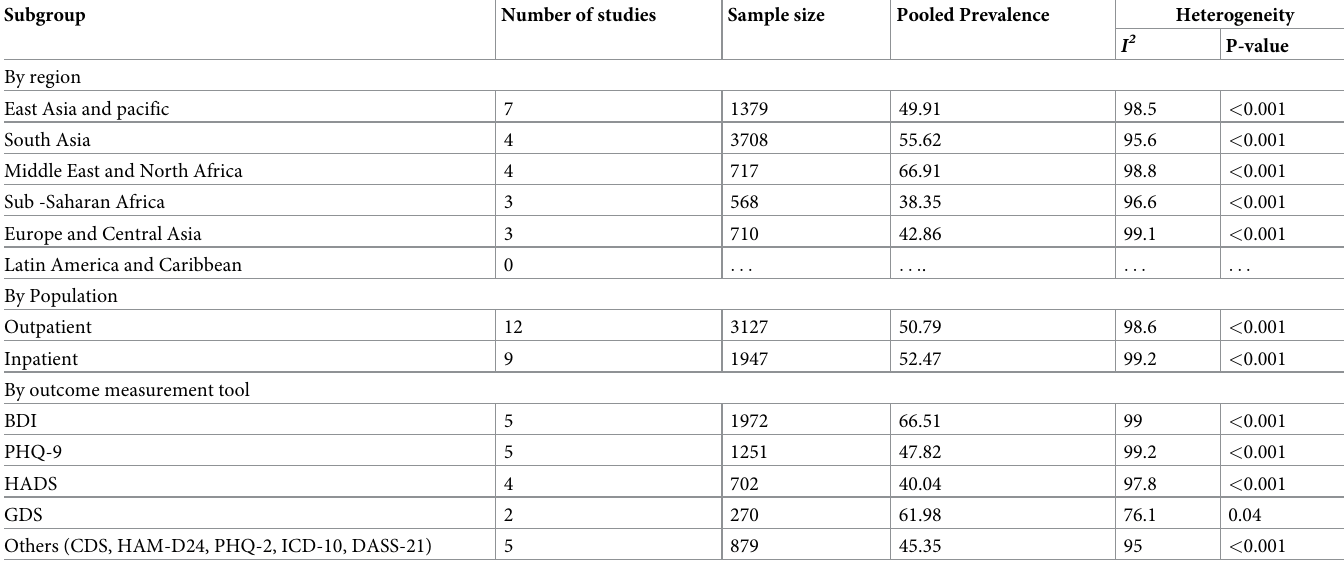
Table 3. Subgroup analysis on the prevalence of depression among people with heart failure in